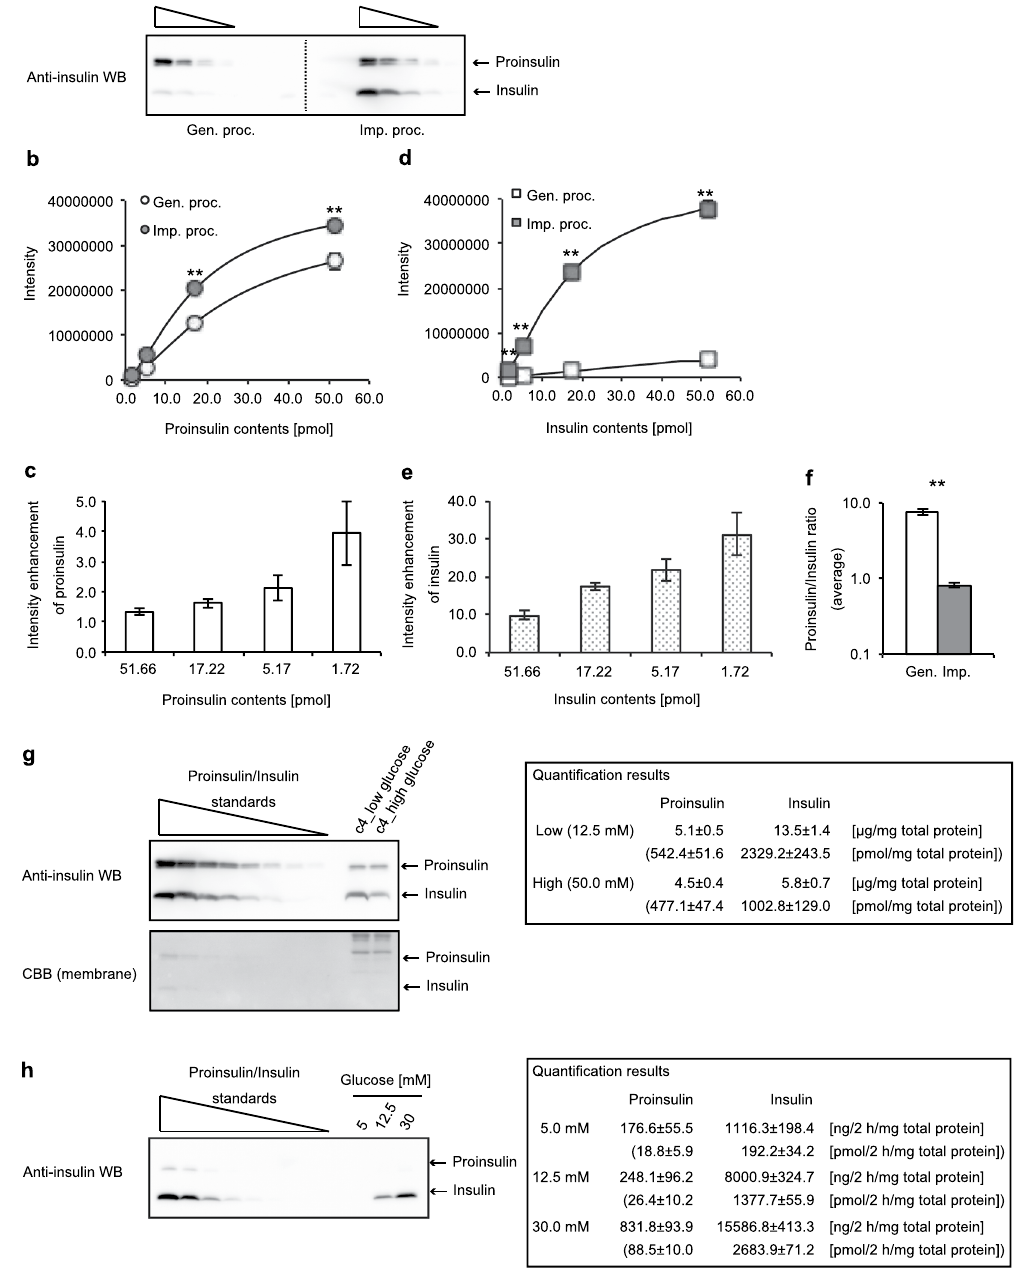
Figure 5. Quantification of insulin contents of a mouse β cell line MIN6c4. Dilution series of equal moles of proinsulin and insulin (range, 51.7 to 1.7 pmol) were subjected to the general (Gen.) or the improved (Imp.) Western blotting (WB) procedure (proc.). The blotted slips for the general or improved protocol were separated from one blotted membrane. ( a ) A representative image from four independent experiments is shown. ( b–e ) The quantification results of proinsulin ( b and c ) and insulin ( d and e ) were obtained from each of the four slips. The data are shown as mean ± S.E. and were analyzed with a Student t -test ( ** p < 0.01). The calibration curves were obtained by four-parameter logistic fitting methods ( b and d ). At each four-plotted point quantified, the enhancement of proinsulin or insulin intensity from the improved procedure against that from the general procedure is shown ( c and e ). ( f ) Proinsulin/insulin molar ratios (PI/I ratios) obtained from the general or improved WB are shown as the average from a PI/I ratio at each dose quantified. The data are shown as mean ± S.E. and were analyzed with a Student t -test ( ** p < 0.01). ( g ) Proinsulin and insulin contents of MIN6c4 cultured under the indicated conditions were calculated from the reference curve (dose range, 51.7 to 0.8 pmol) (n = 4). ( h ) Proinsulin and insulin contents secreted from MIN6c4 cells under the indicated conditions were calculated from the reference curve (dose ranges: proinsulin, 215.2 to 3.4 fmol; insulin, 2152.4 to 33.6 fmol) (n =